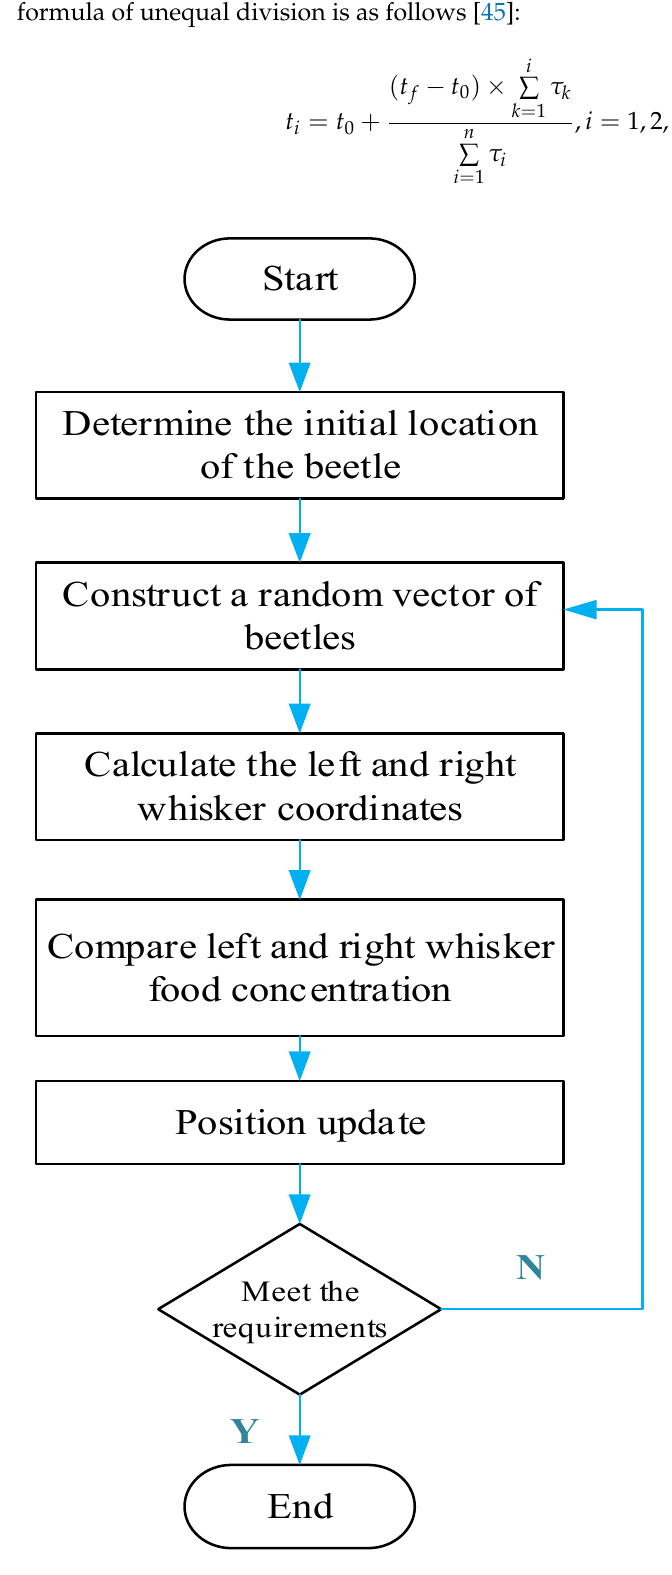
Figure 2. BAS algorithm fl ow.